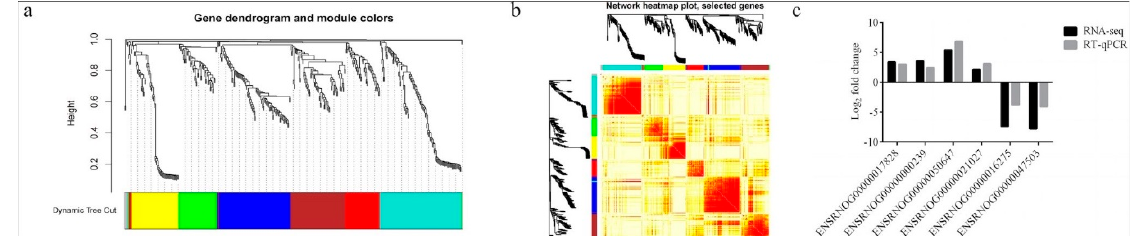
Figure 3. ( a ) WGCNA analysis clustering dendrogram. ( b ) Heatmap of the degree of difference be- tween genes analyzed by WGCNA. ( c ) Comparison of transcriptome and RT-qPCR results. WGCNA: weighted correlation network analysis.